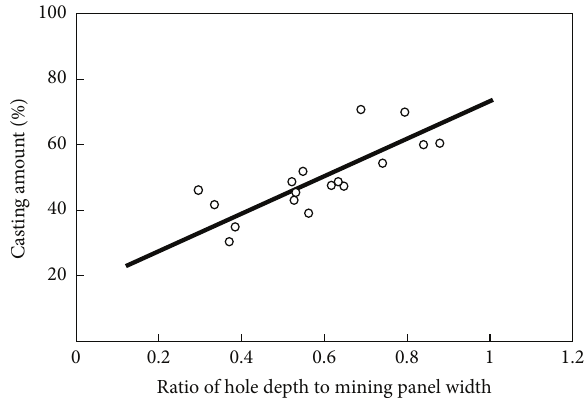
Figure 3: Relationship between casting volume and bench height with mining panel